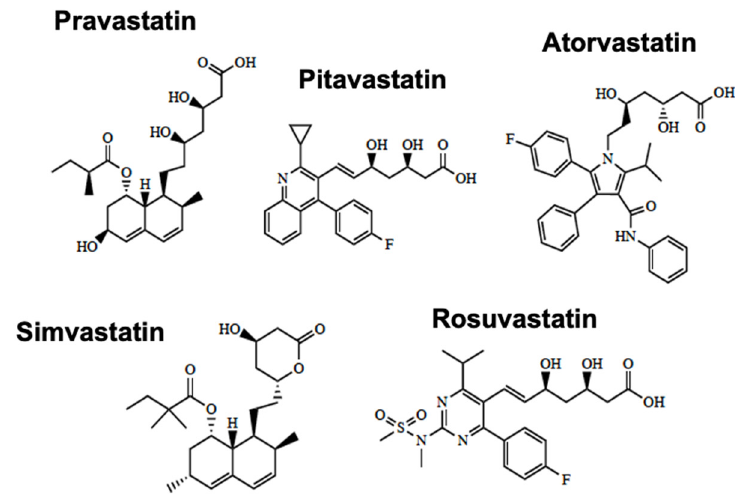
Figure 3. Chemical Structures of Currently Marketed Statin Drugs.